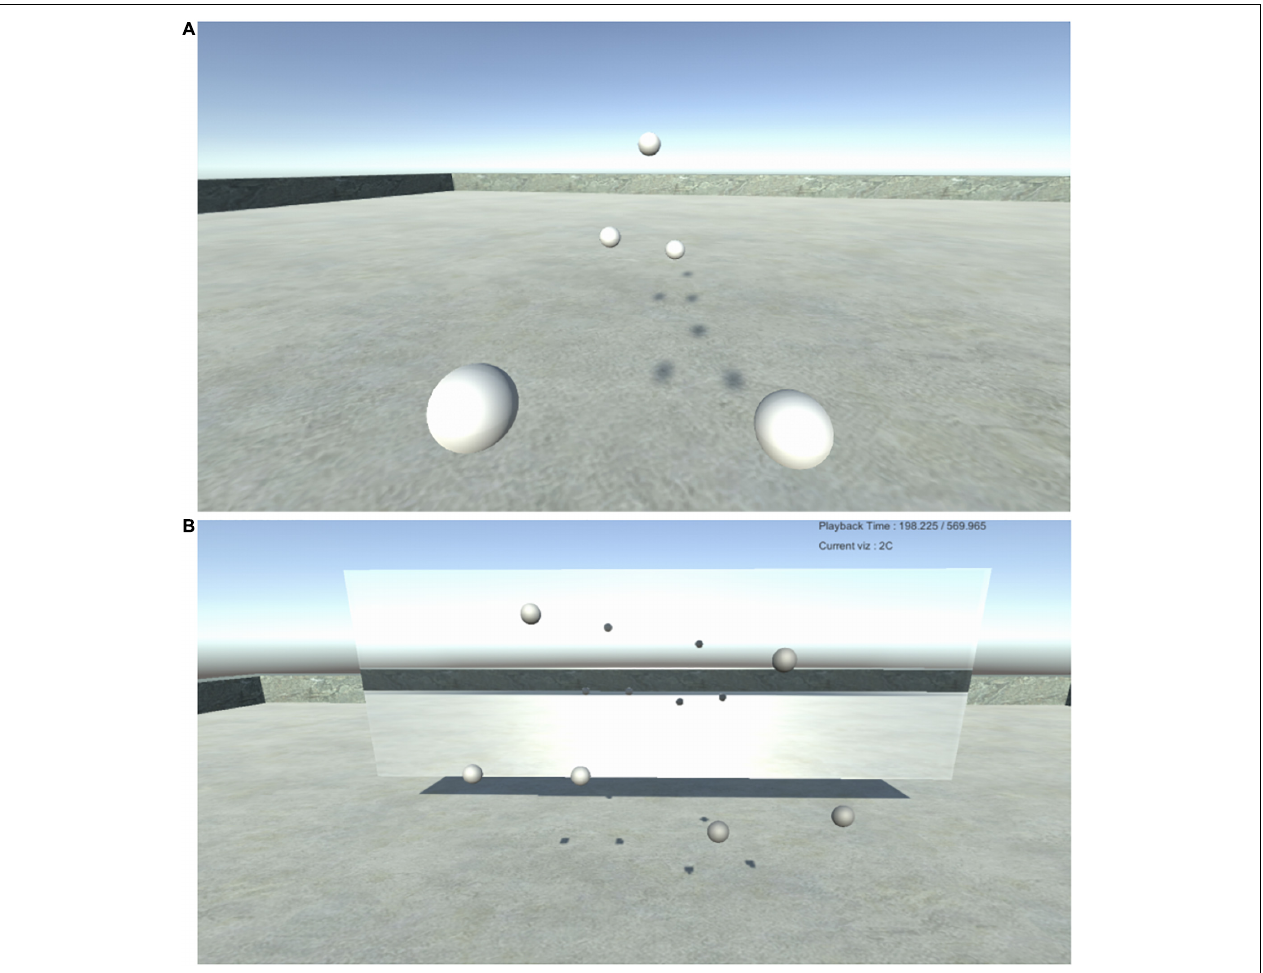
FIGURE 3 | (A) Baseline condition: Visualization of the scenery from a first person point of view. The two closest spheres correspond to the participant’s hands. The three spheres at the back of the image correspond to the position of the head and two hands of their partner. Shadows of the floating objects are visible on the ground. (B) Mirror scenario: Visualization from a third person point of view. Here both participants are standing side to side in front of their own